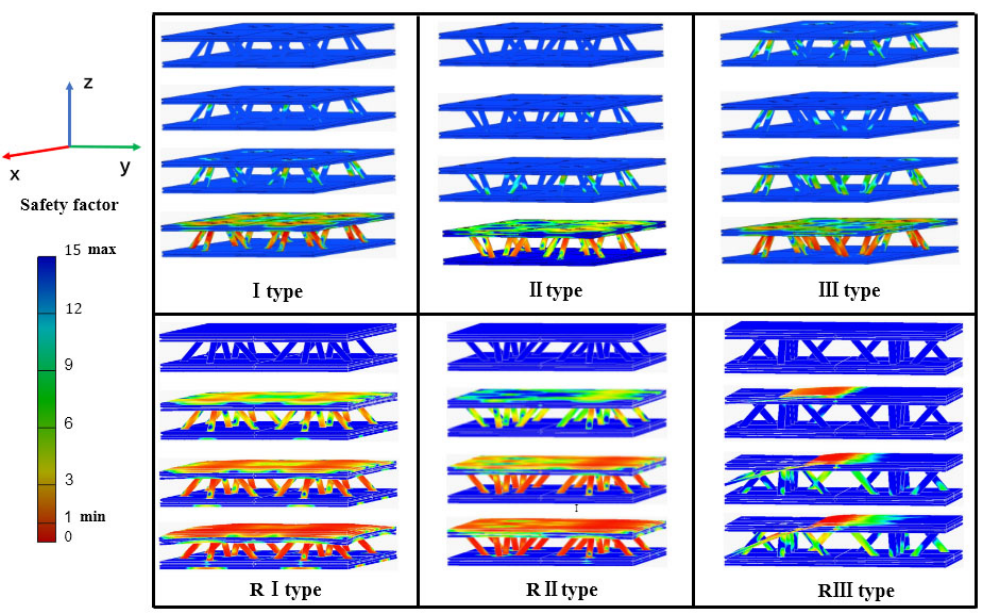
Figure 12. Safety factor distribution of the simulation structure.